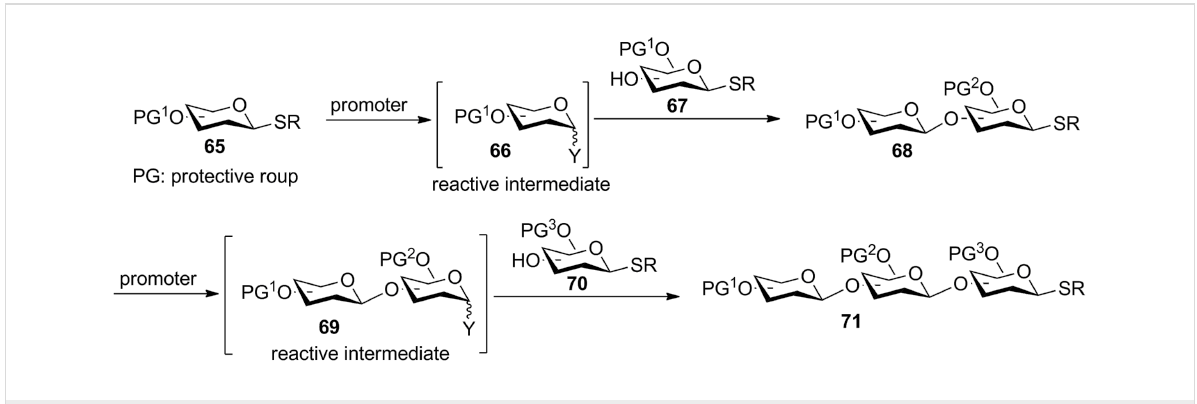
Scheme 13: Preactivation-based iterative glycosylation of thioglycosides.